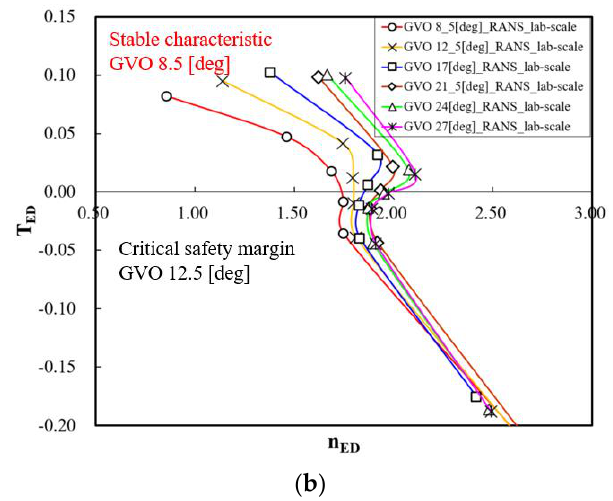
Figure 9. S-shaped characteristics of model scales at 21.5° GVO: ( a ) Speed factor vs. discharge factor; ( b ) speed factor vs. torque factor.